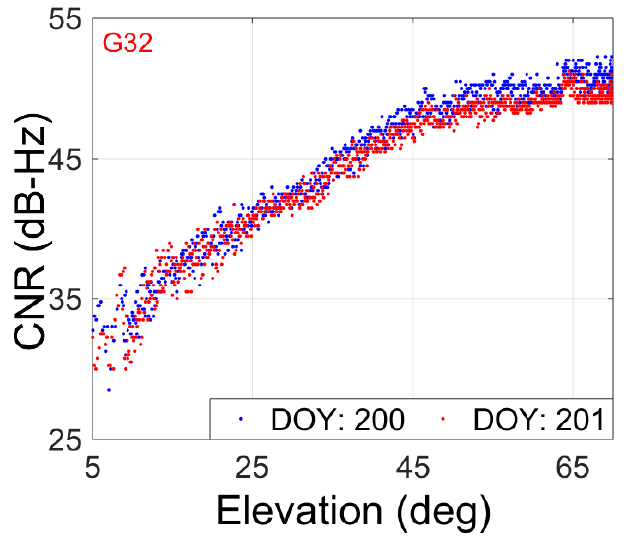
Figure 10. CNR of GPS G32 satellite L1 frequency comparison results with elevation as the horizontal axis. The blue and red dots denote the CNR collected on DOY:200 (no flood) and DOY:201 (with flood), 2021, respectively.